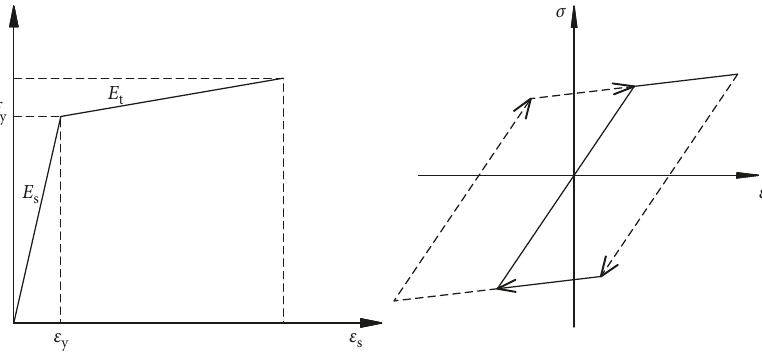
Figure 9: Bilinear kinematic hardening